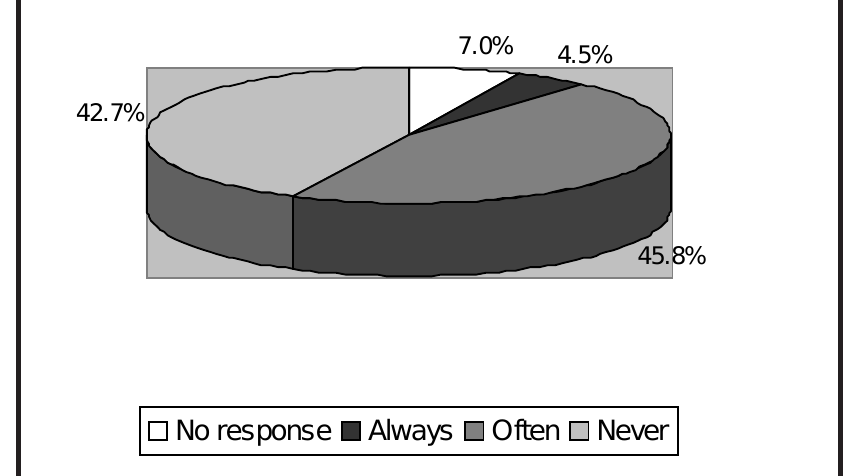
Figure 1 Frequency of going to bed